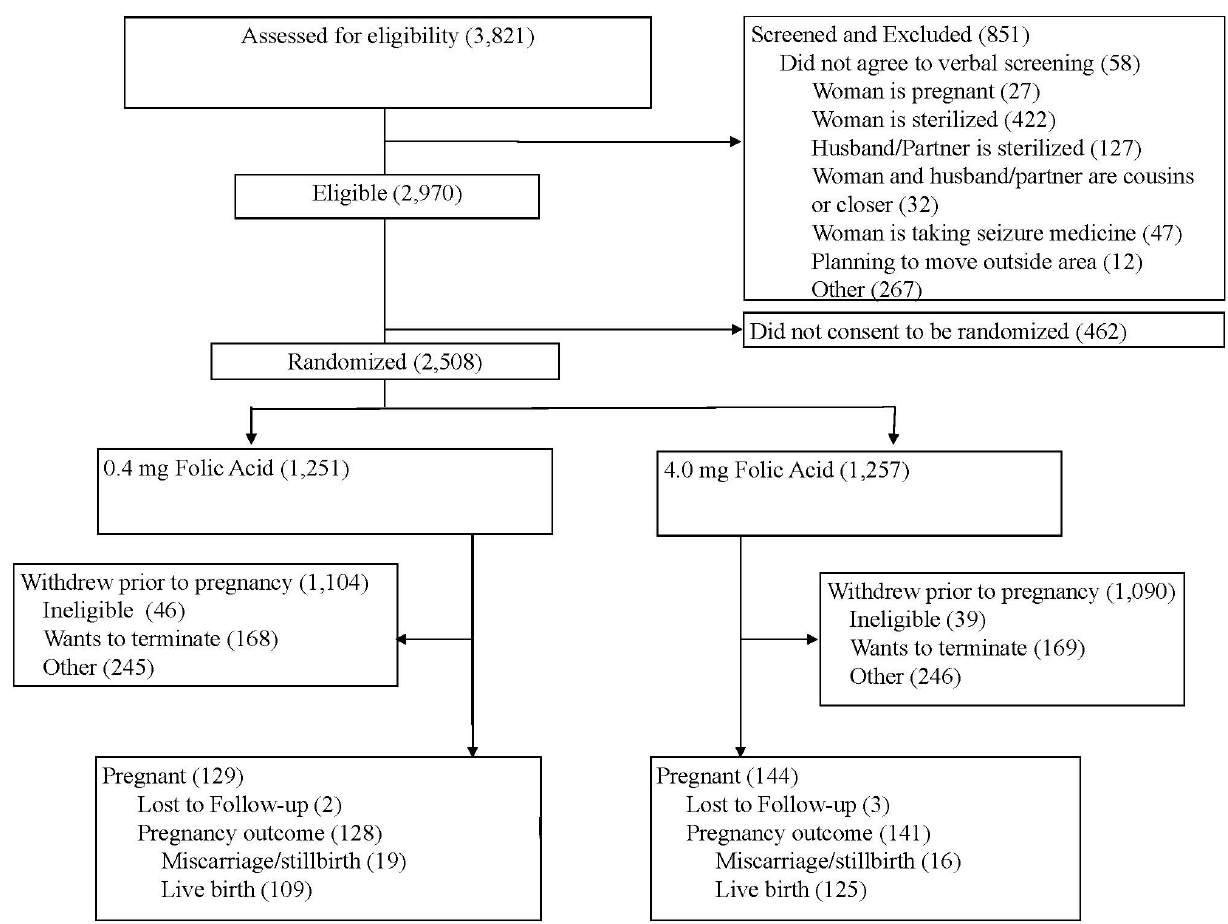
Figure 1. Study flow